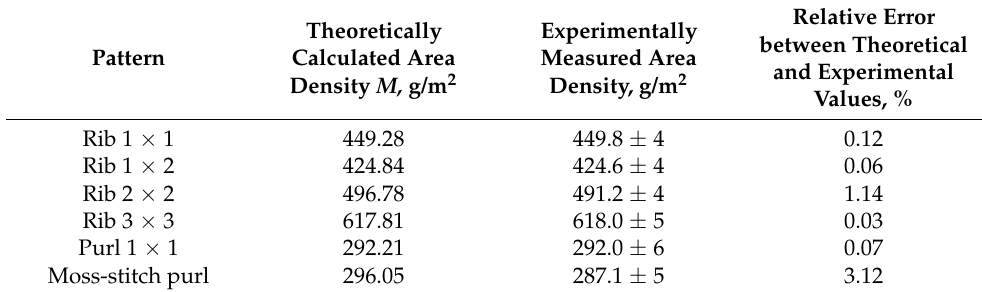
Table 5. Area density and relative error between the theoretically calculated and experimentally measured